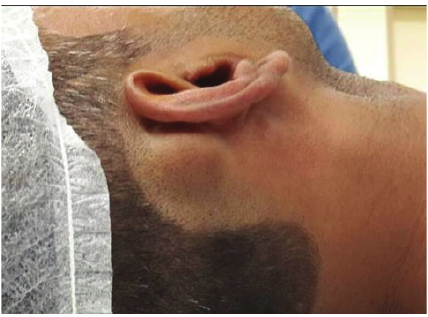
Figure 1: Osteoma external appearance.